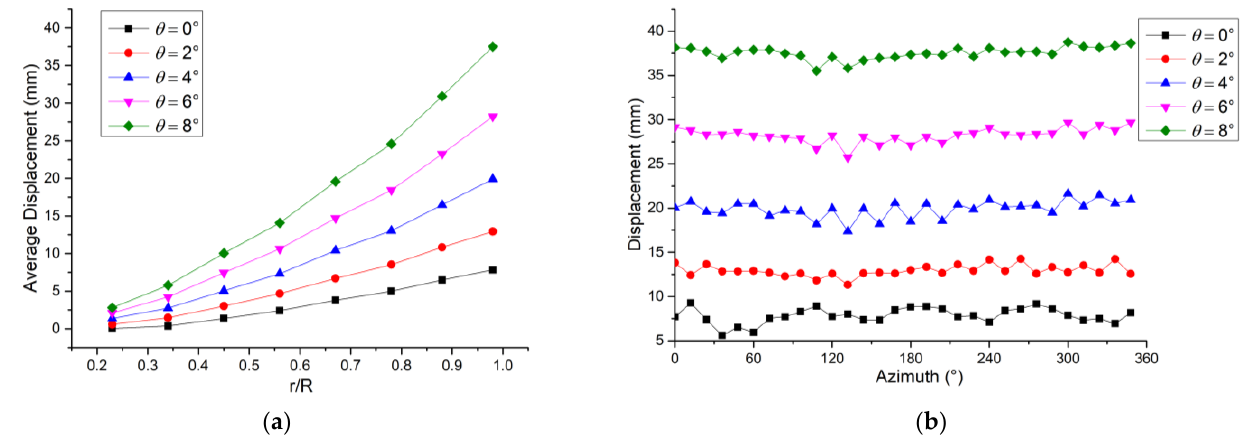
Figure 12. ( a ) Average displacements at eight radial locations of the rotor blade. ( b ) Blade tip displacements at five collective pitch angles.